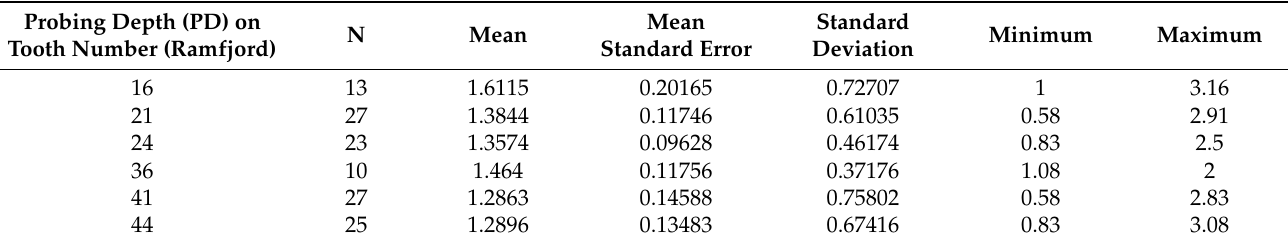
Table 2. PD values on Ramfjord